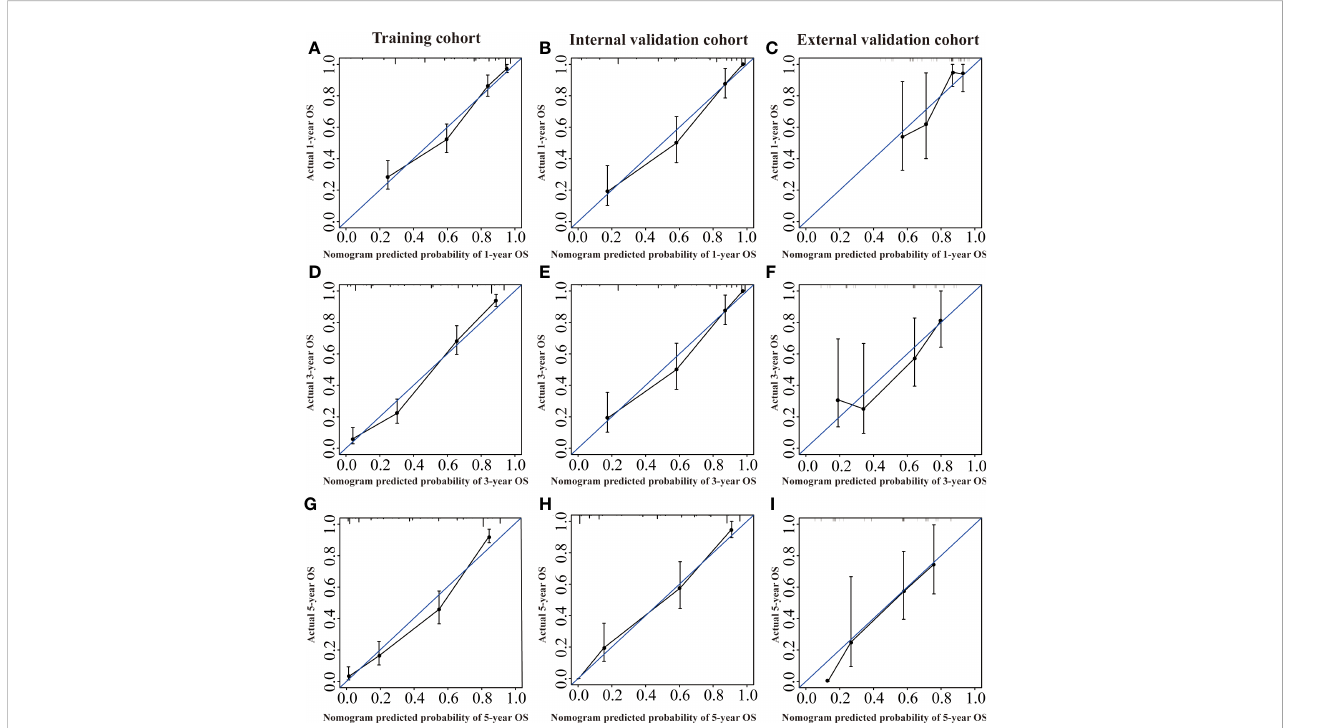
FIGURE 5 Calibration curves of the nomogram of CRNENs for 1, 3, and 5-year OS rates in the training cohort (A, D, G) , the internal validation cohort (B, E, H) , and the external validation cohort (C, F, I) . CRNENs, colorectal neuroendocrine neoplasms; OS, overall survival.